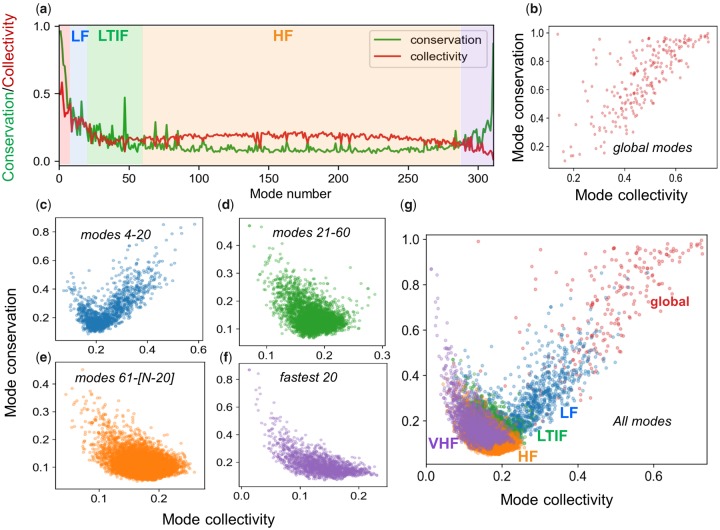
Correlation between mode conservation and mode collectivity. (a) Comparison of the conservation (green) and collectivity (red) profiles of all modes, illustrated for 3′5′-cyclic nucleotide phosphodiesterase, catalytic domain (CATH id: 1.10.1300.10). The different frequency regimes of the mode spectrum are indicated by semitransparent color-coded shades (red: global; blue: LF; green: LTIF, orange: HF and violet: VHF). (b–f). Mode conservation versus mode collectivity scatter plots for the GNM mode spectra of 15,636 proteins belonging to 77 CATH superfamilies, in five different frequency regimes, as labeled. Panel (g) displays all modes (from b to f) on the same plot, with the abscissa and ordinate representing the collectivity and conservation, respectively, of the modes in each family.